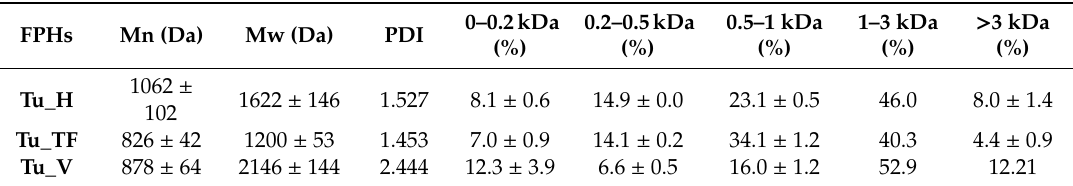
Table 4. Average molecular weights (as Mn and Mw) and associated confidence intervals for n = 5 (samples from di ff erent hydrolysates) and α = 0.05. Percentage of peptides distribution between molecular weight ranges was also determined. PDI: polydispersity index.